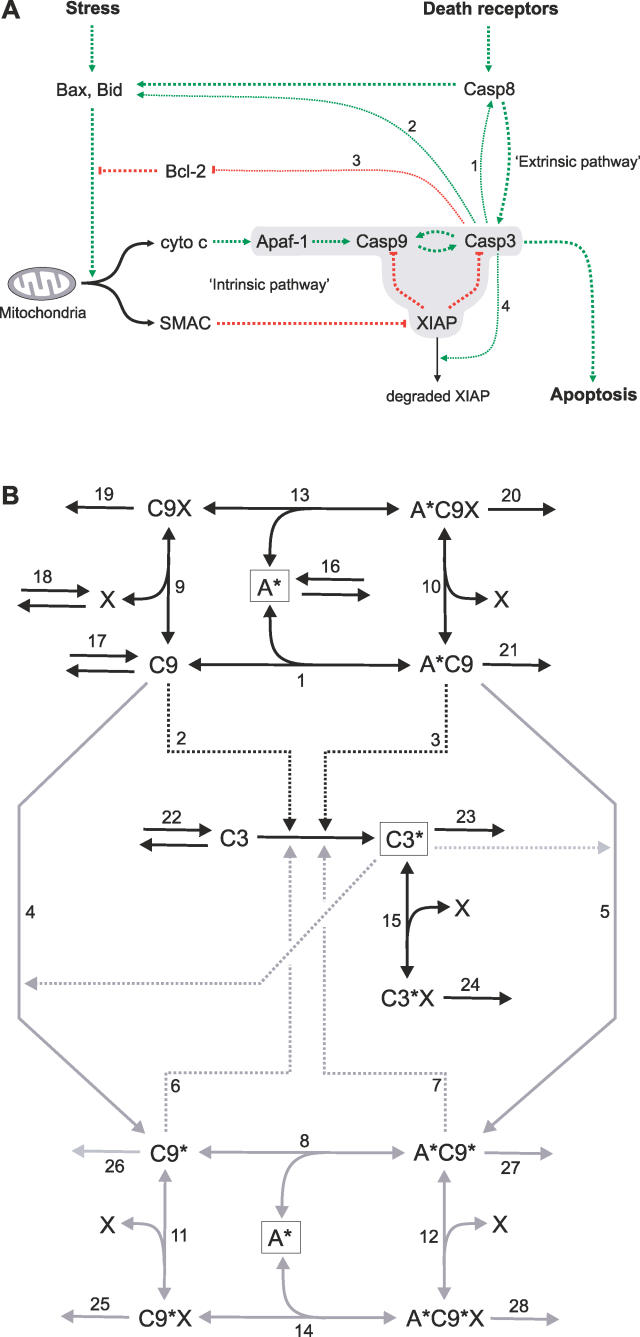
Mathematical Model of the Intrinsic Apoptosis Pathway(A) Schematic representation of intrinsic and extrinsic apoptosis pathways. Dotted lines indicate positive (green) or negative (red) regulation, and the solid lines refer to release of Smac and cyto c from mitochondria. The regulatory interactions considered in the model are highlighted in gray. The numbers 1–4 refer to additional feedbacks described in the Discussion.(B) Kinetic scheme of the model. The reactions depicted in gray, which are involved in Casp3-mediated feedback cleavage of Casp9, were eliminated in the Casp9-mutant model in order to dissect the role of XIAP-mediated feedback.A*, activated Apaf-1; C3, Casp3; C9, Casp9.